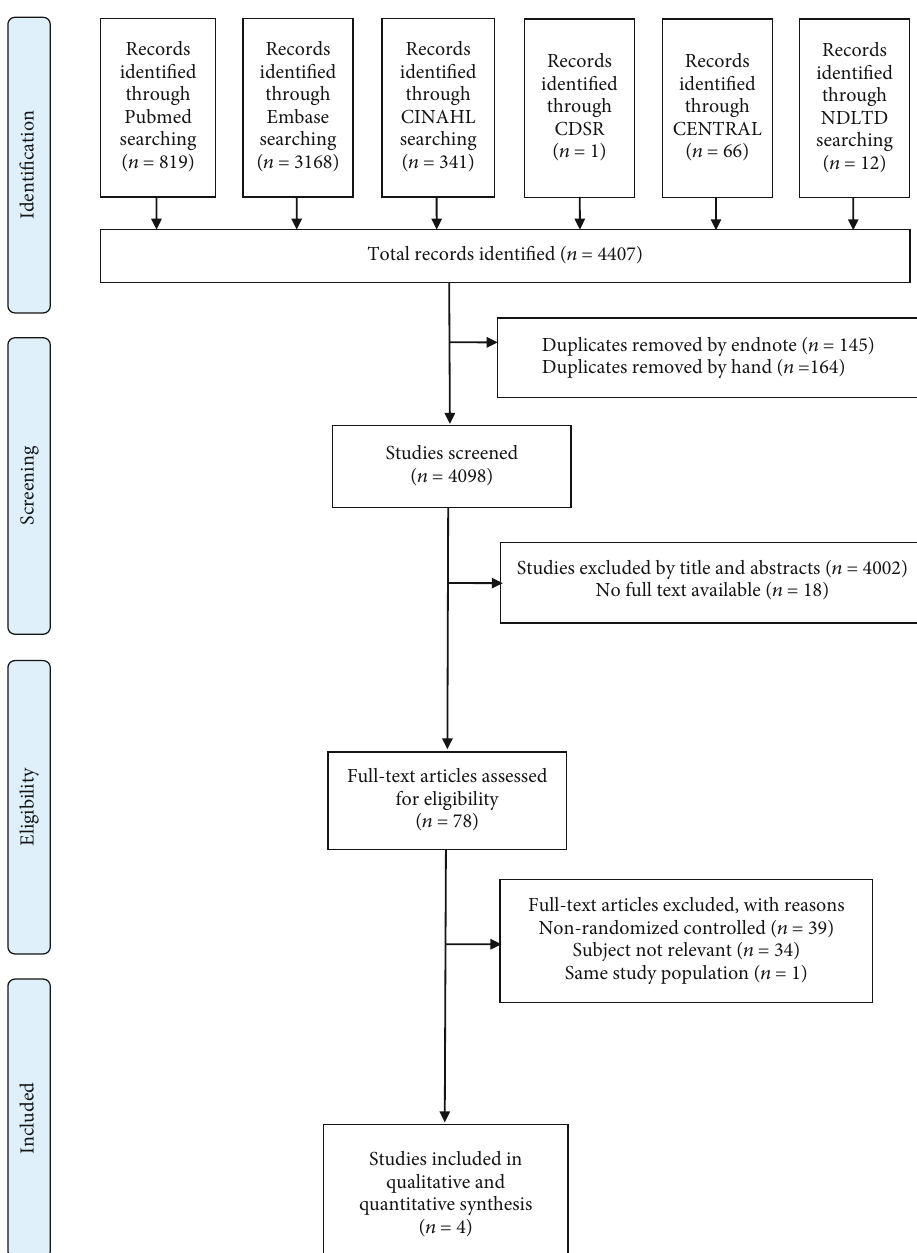
Figure 1: PRISMA study selection fl ow diagram. CINAH: Cumulative Index to Nursing and Allied Health; CDSR: Cochrane Database of Systematic Reviews; CENTRAL: Cochrane Central Register of Controlled Trials; NTLTD: Networked Digital Libraries of Theses and